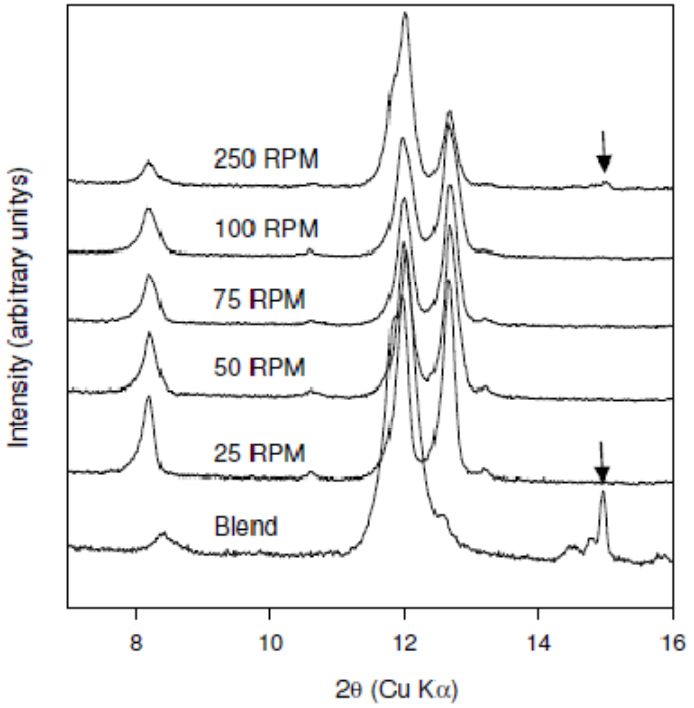
Figure 5. XRPD patterns of the material obtained from using the mixing design at 25 °C as a function of screw speed shown comparison to the preblend. Caffeine reflections are marked with an arrow. Screw speed (residence time) has a minimal impact on the extent of conversion to the